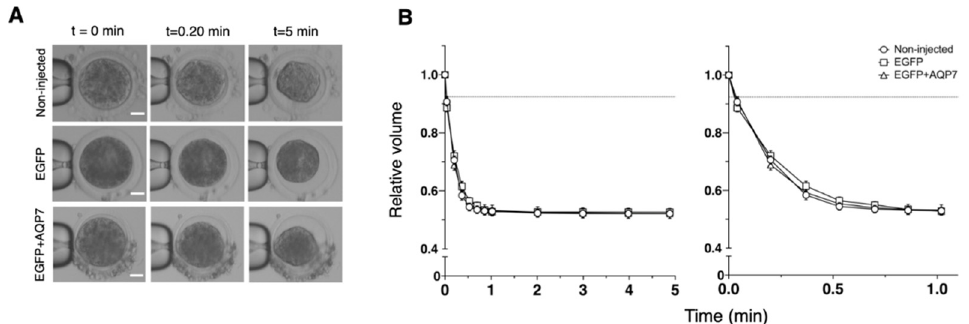
Figure 4. Osmotic behavior of non-injected MII bovine oocytes (circles), EGFP cRNA-injected (squares), or EGFP+AQP7 cRNA-injected-oocytes (triangles) exposed to 0.5 M sucrose for 5 min at 25 °C. ( A ) Representative phase-contrast microscopy images of oocytes measured in B. Scale bar, 30 µm. ( B ) Summary data represented as the relative mean volume ± SEM. Non-injected oocytes: n = 10; EGFP cRNA-injected oocytes: n = 12 and EGFP+AQP7 cRNA-injected oocytes: n = 12.